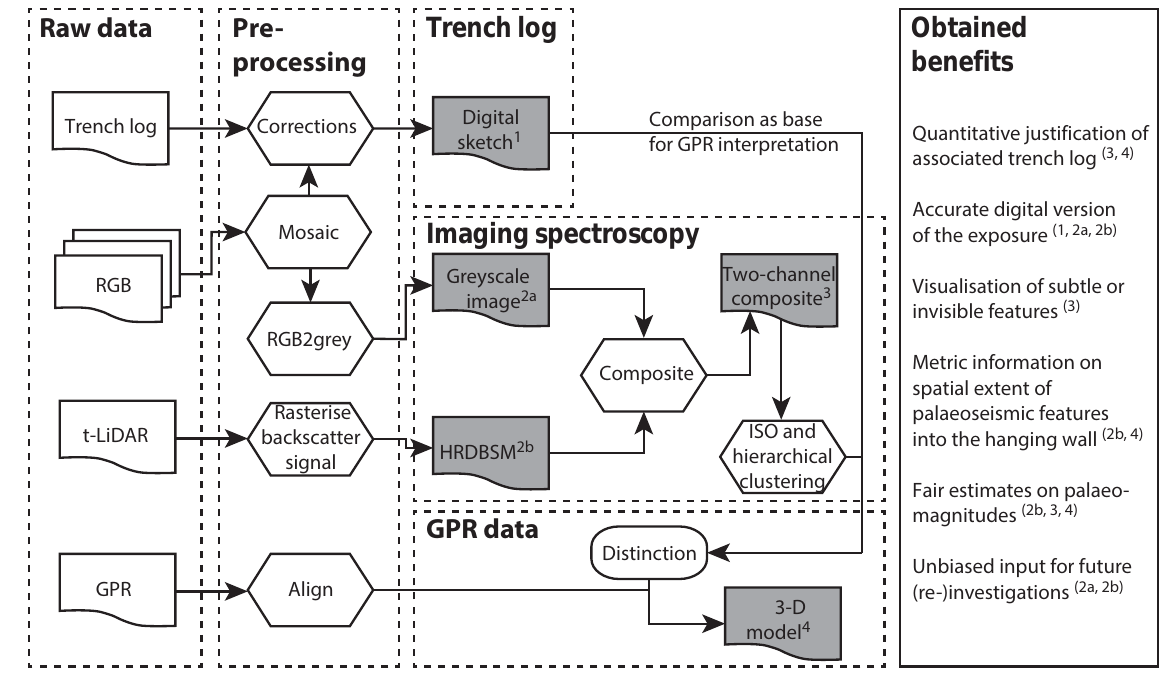
Figure 3. Flowchart of conventional trench logging, imaging spectroscopy and GPR survey; their comparison and combination. Palaeoseis- mological studies benefits from one or multiple data sets (grey) generated with this